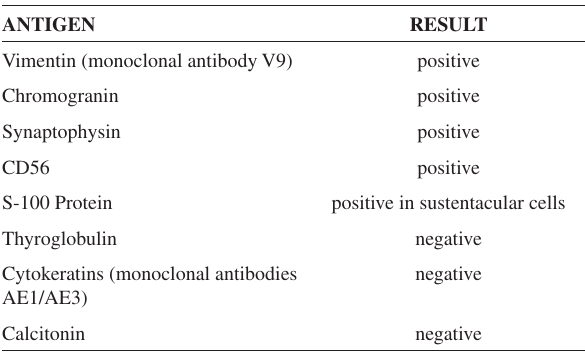
Table 1 - Immunohistochemical panel of antibodies of the present